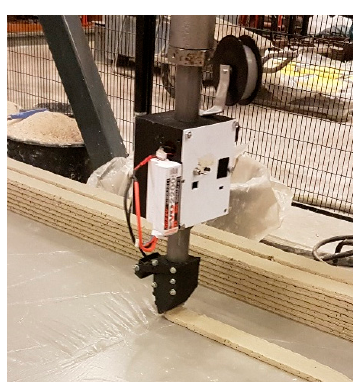
Figure 2. Active reinforcement entrainment device (RED) for cable reinforcement of printed concrete.